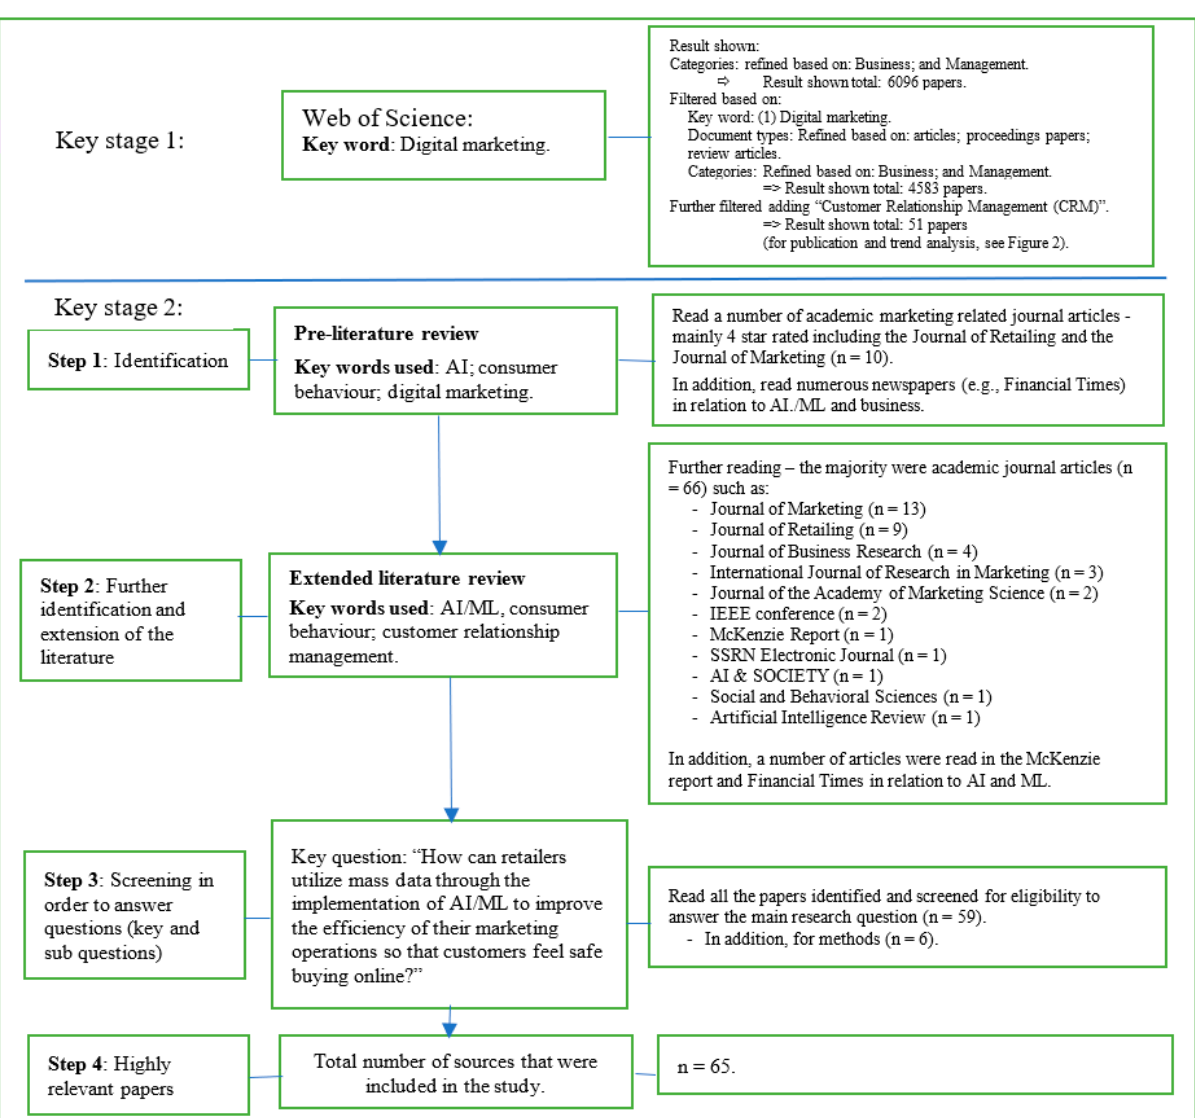
Figure 2. Digital marketing and customer relationship management—Trend analysis of publications 2008 to January 2022. (n = 51). Source: The authors.